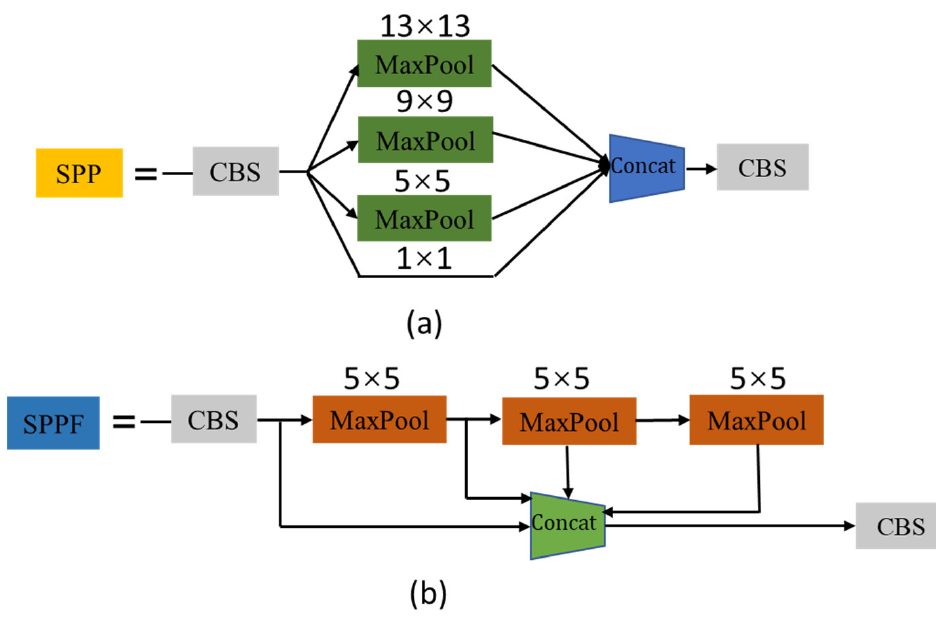
Figure 7. ( a ) SPP structure diagram and ( b ) SPPF structure diagram.